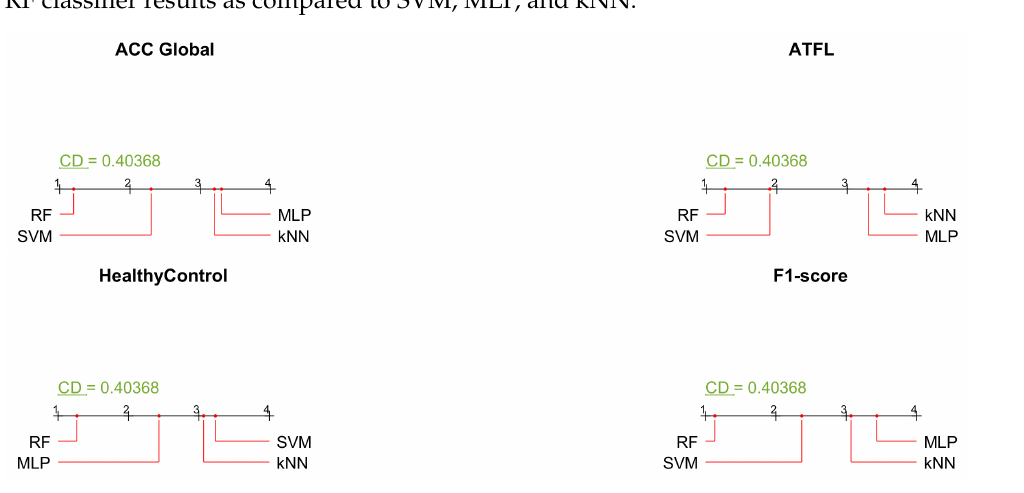
Figure 7. Critical Distance diagrams for performance metrics of the machine learning methods.